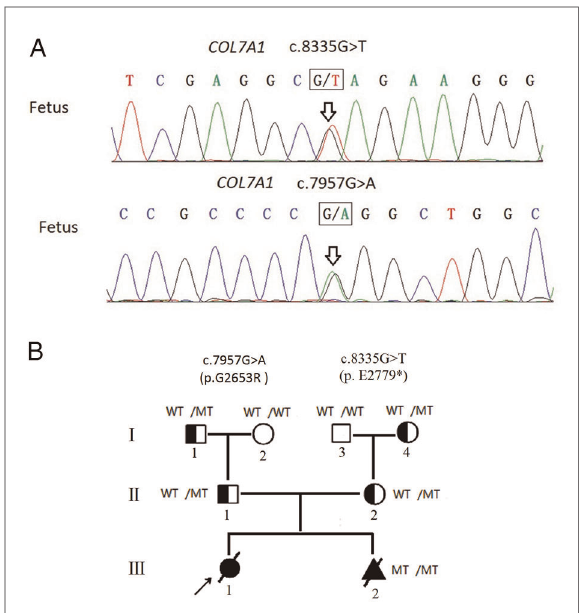
FIGURE 1 ( A ) Fetus carried two compound heterozygous variants (c.8335G>T, c.7957G>A), which were inherited from the father and the mother separately. ( B ) Pedigree analyses to identify the family members with RDEB. The proband is indicated by an arrow. The black circle indicates affected family members; the triangle represents the induced fetus; MT indicates the heterozygous c.7957G>A variant or heterozygous c.8335G>T variant; diagonal bars through the symbols denote deceased individuals. The proband did not undergo genetic